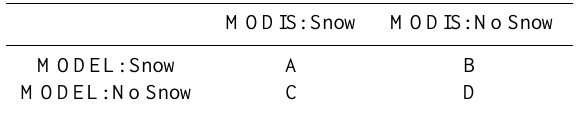
Table 3. Confusion matrix for MODIS-derived and model- simulated SCAs for snow seasons of October 2000 through Septem- ber 2004. A, B, C, and D represent number of grids in a particular classification category. MODIS: Snow MODIS: No Snow MODEL: Snow A B MODEL: No Snow C